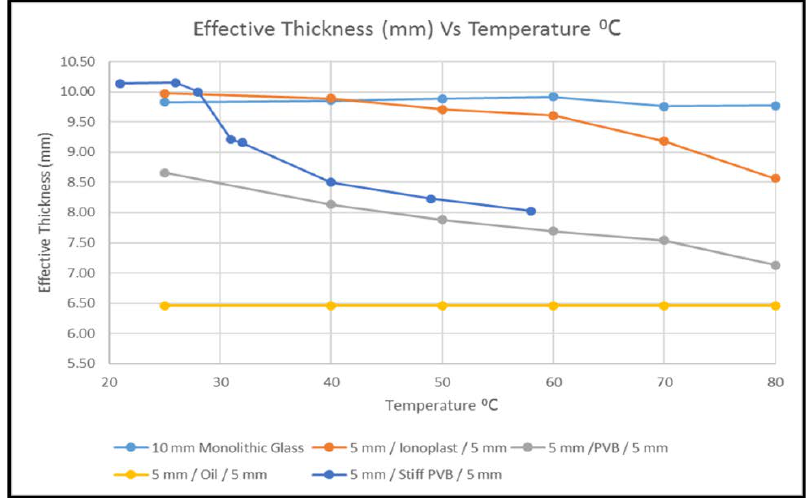
Fig. 2 Effective Thickness of PVB, Stiff PVB and Ionoplast vs Temperature